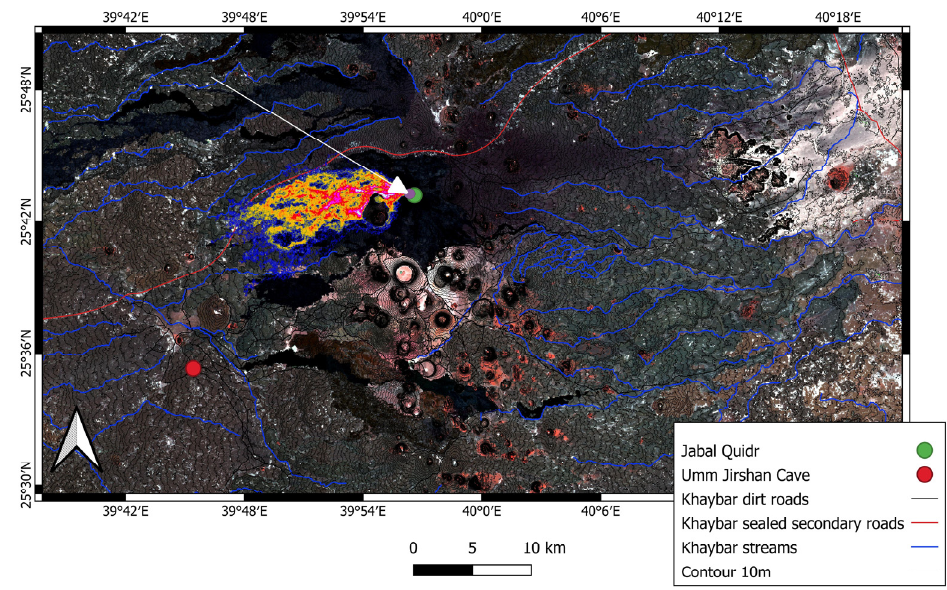
Figure 19. JQ2 (green dot just below the summit of Jabal Quidr, marked by purple dot and a white arrow) using 5 m (10 m) Euclidean simulation with 500 km simulation distance. Results overlay the SWIR satellite image of the region. Red dots mark the Umm Jirsan lava tube (data are from Open Street View).